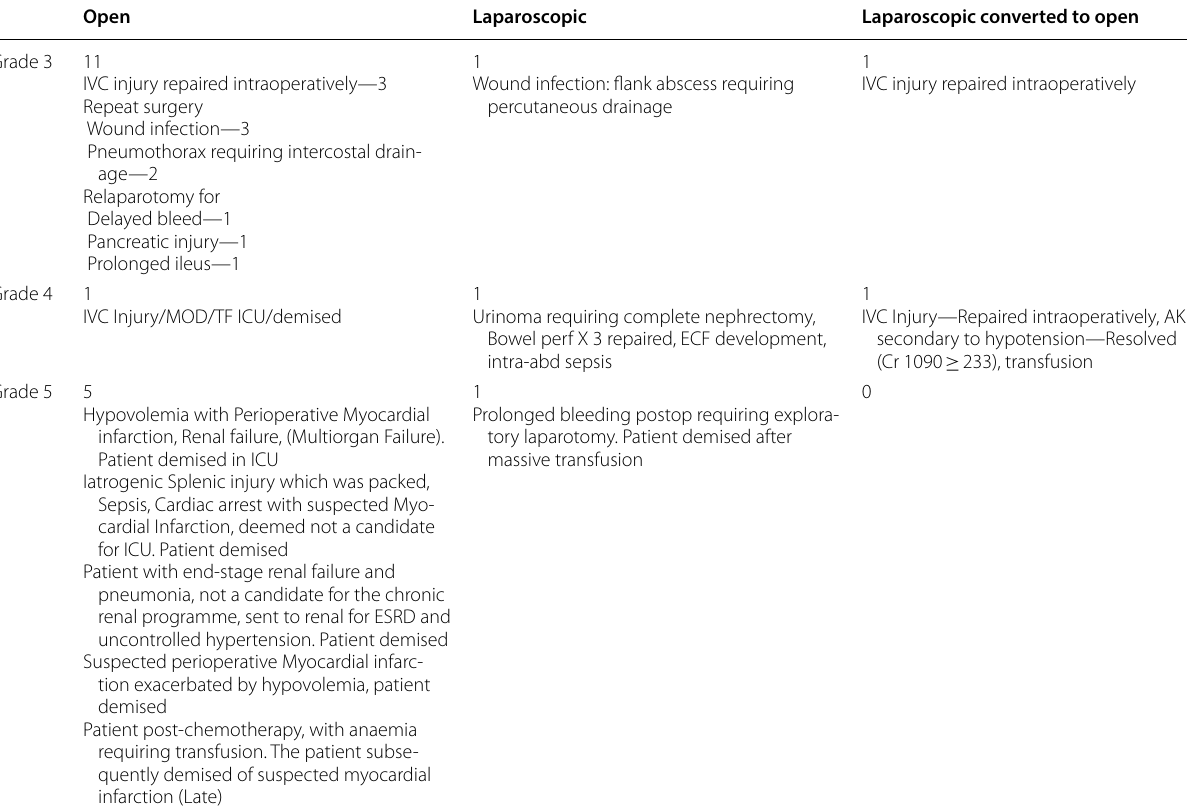
Table 5 Details of severe